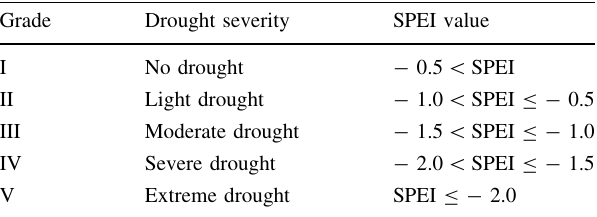
Table 1 Drought level classification for the Heihe River Basin